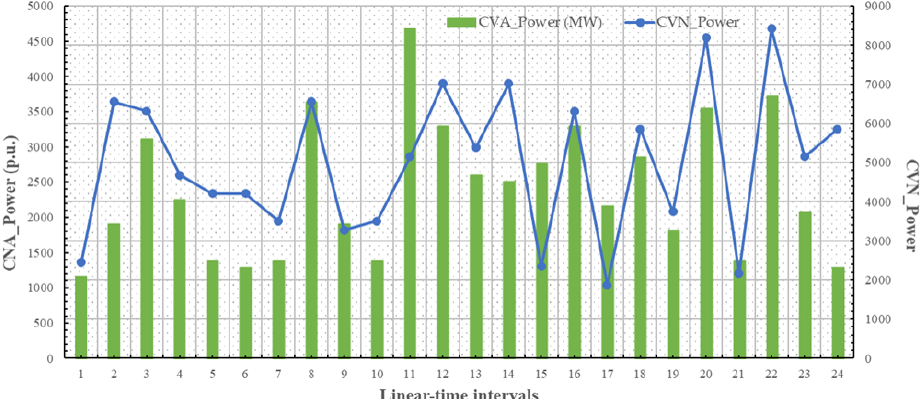
Figure 8. Over-limit numbers and amounts of traditional optimal power flow on branch power.